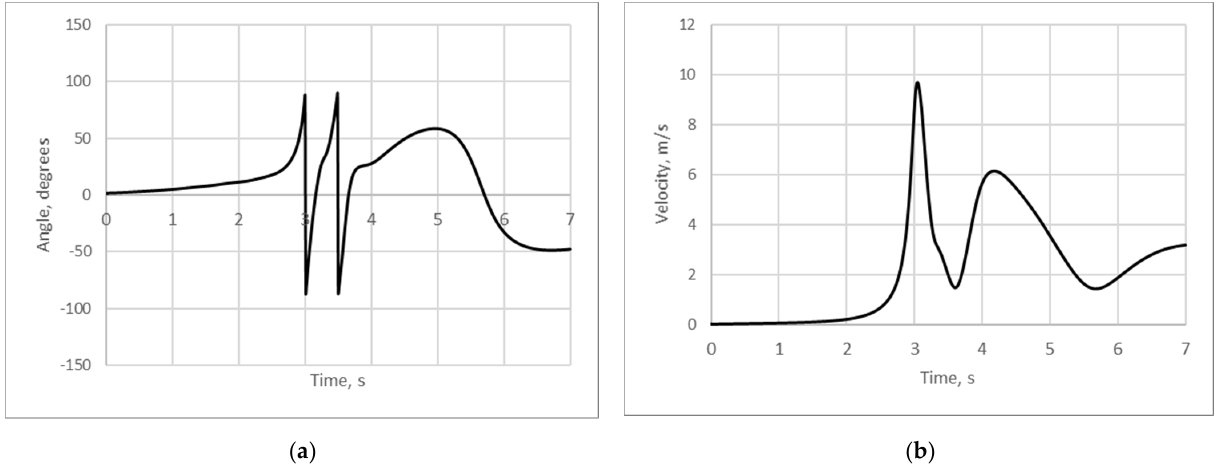
Figure 14. ( a ) Instantaneous wind direction at the rotor zone for bus model; ( b ) Instantaneous wind magnitude at the rotor zone for bus model.